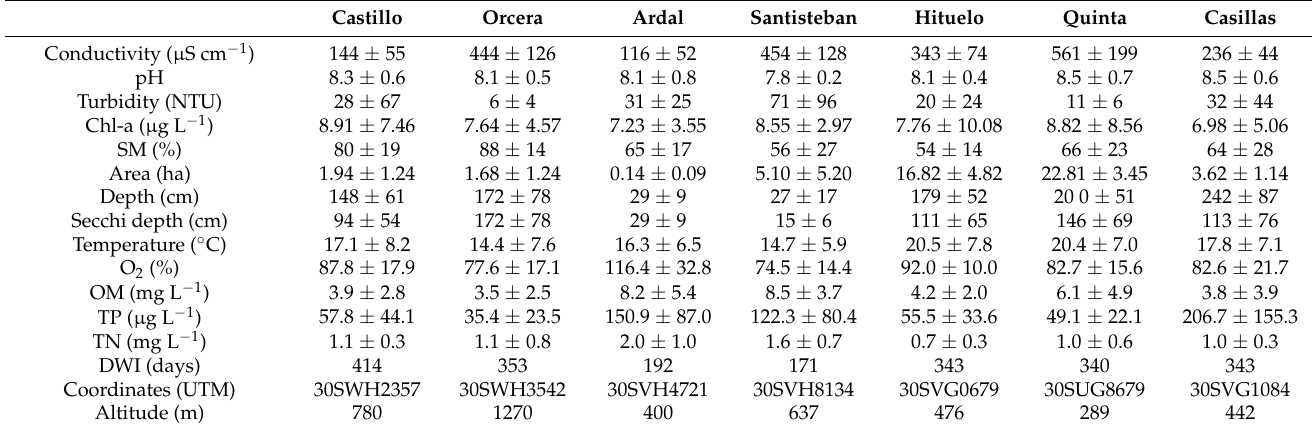
Table 1. Mean and standard deviation of limnological variables measured in the studied ponds. Castillo Orcera Ardal Santisteban Hituelo Quinta